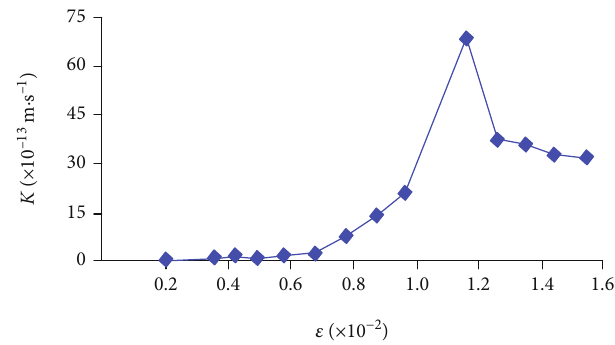
Figure 7: Variation curve of the permeability coe ffi cient K with strain ε .